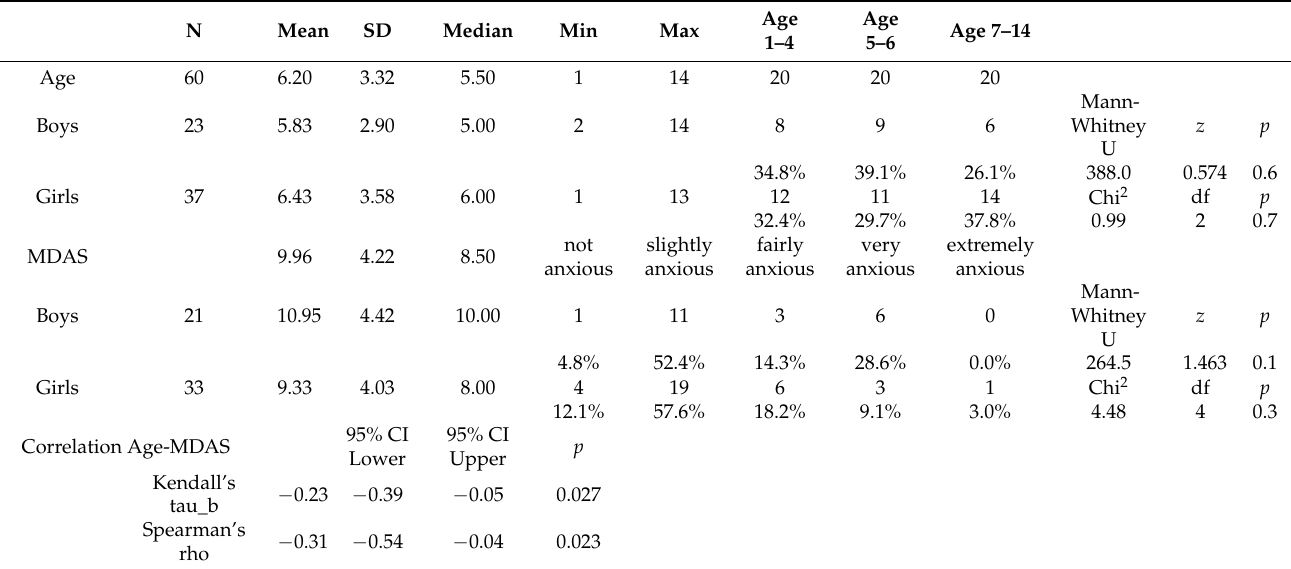
Table 3. Distribution of age and MDAS by gender, and relation of MDAS with